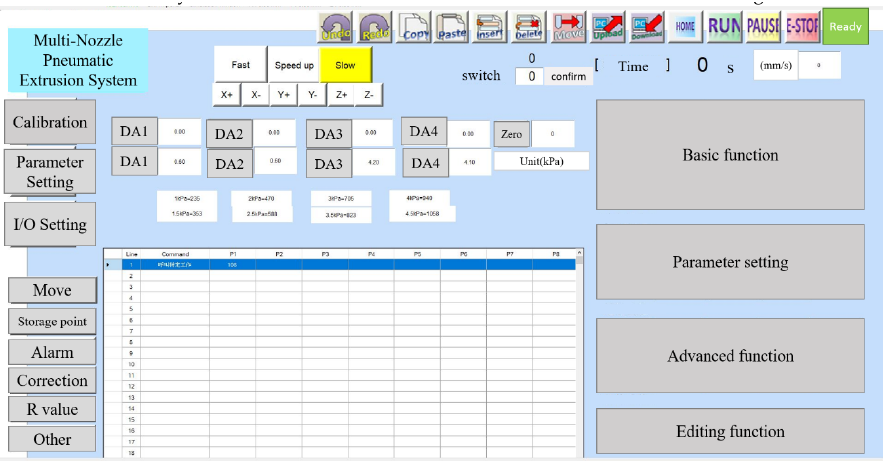
Figure 5. e-HMI system design.